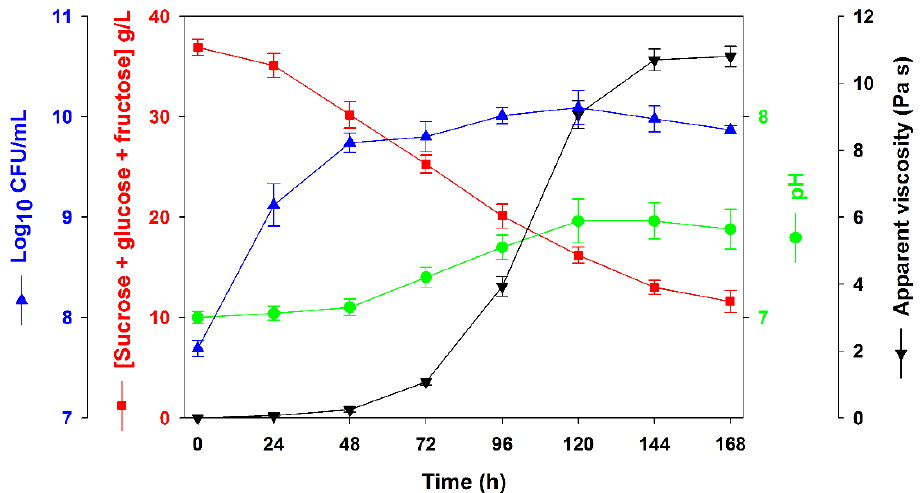
Figure 3. Time course of apparent viscosity (Pa s), colony-forming units (Log 10 CFU/mL), sugars consumption (g/L) and pH in assays performed with Rhizobium viscosum CECT908 grown in the alternative low-cost medium (CSLM) at 28 °C and 180 rpm. The results represent the average of triplicate experiments ± standard deviation.